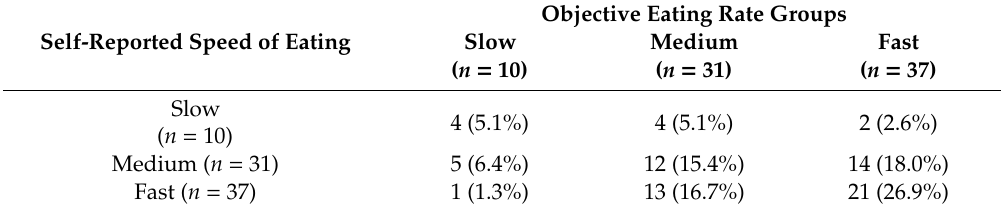
Table 3. Percentage agreement between self-reported and objective eating rate categories, n (%)